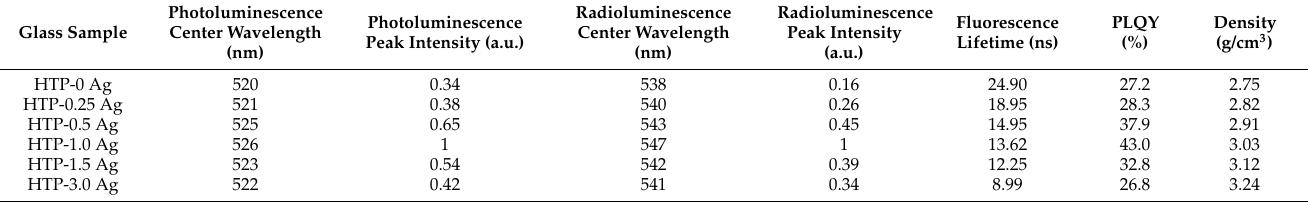
Figure 10. ( a ) X-ray excitation scintillation spectra of CsPbBr 3 QD-doped glasses containing Ag NPs and ( b ) their radioluminescence and photoluminescence intensity comparison graph. Table 1. Scintillation performances of CsPbBr 3 QD-doped glasses containing Ag NPs.